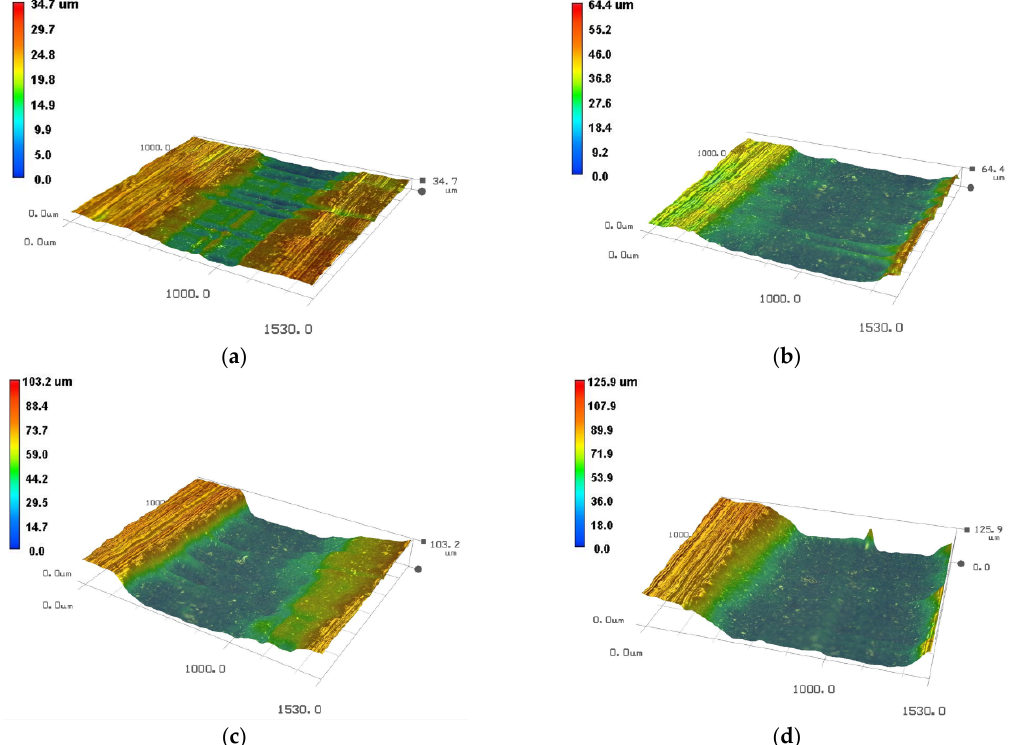
Figure 5. The 3D pit topographies of substrate 90° sample at different time. ( a ) 150 min; ( b ) 270 min; ( c ) 330 min; ( d ) 390 min.